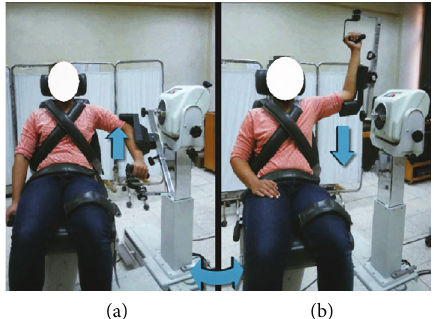
Figure 3: Shoulder external and internal rotators isokinetic testing: